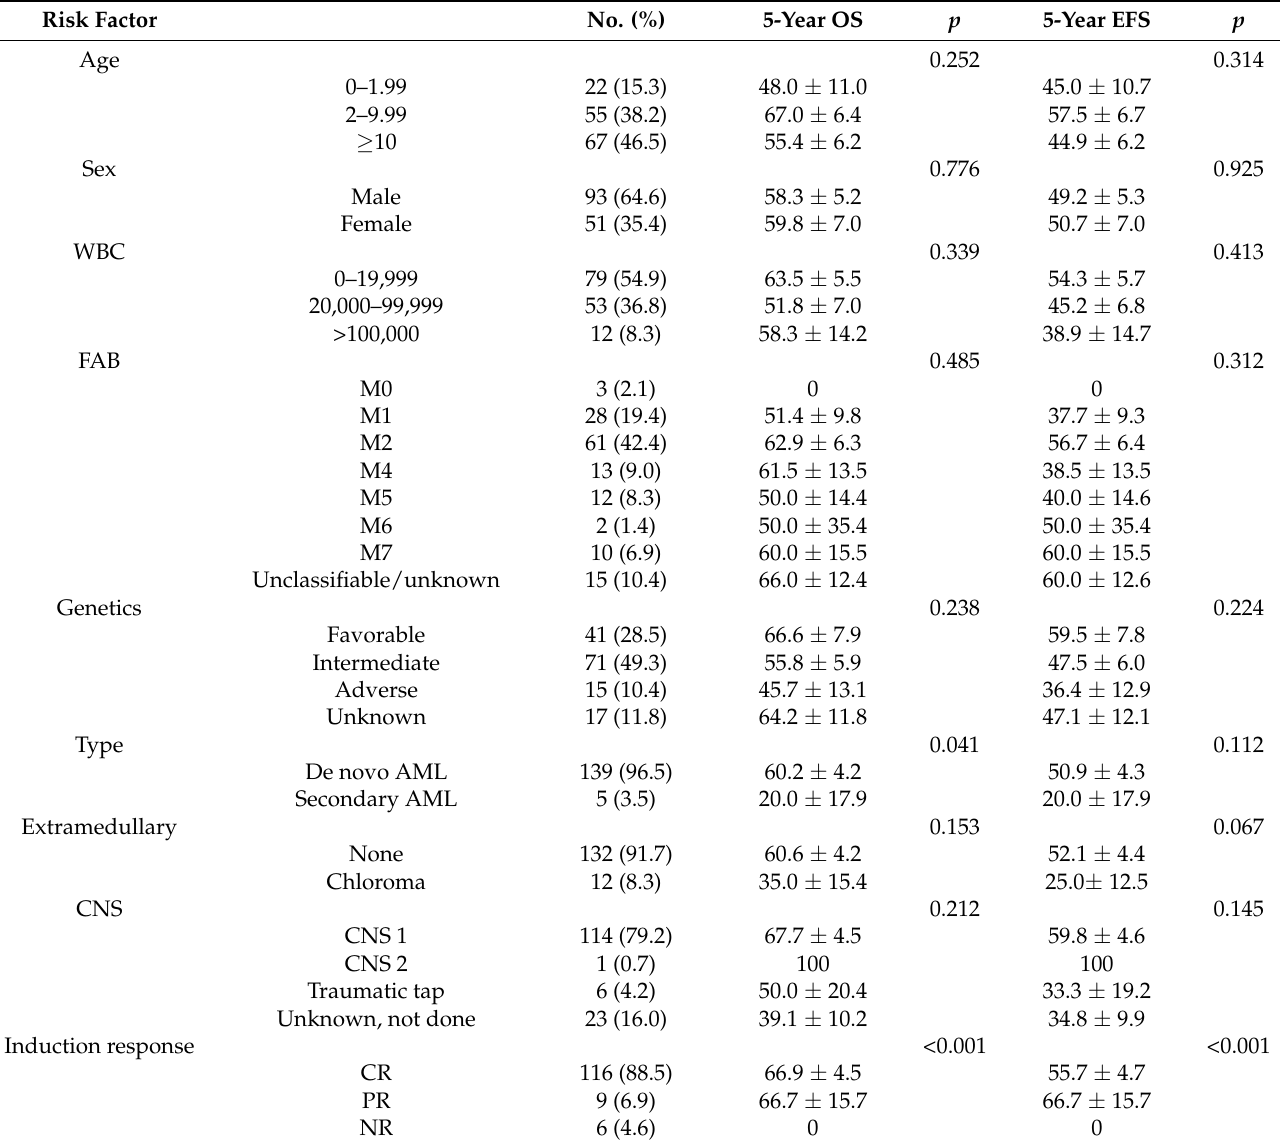
Table 3. Univariate analysis of